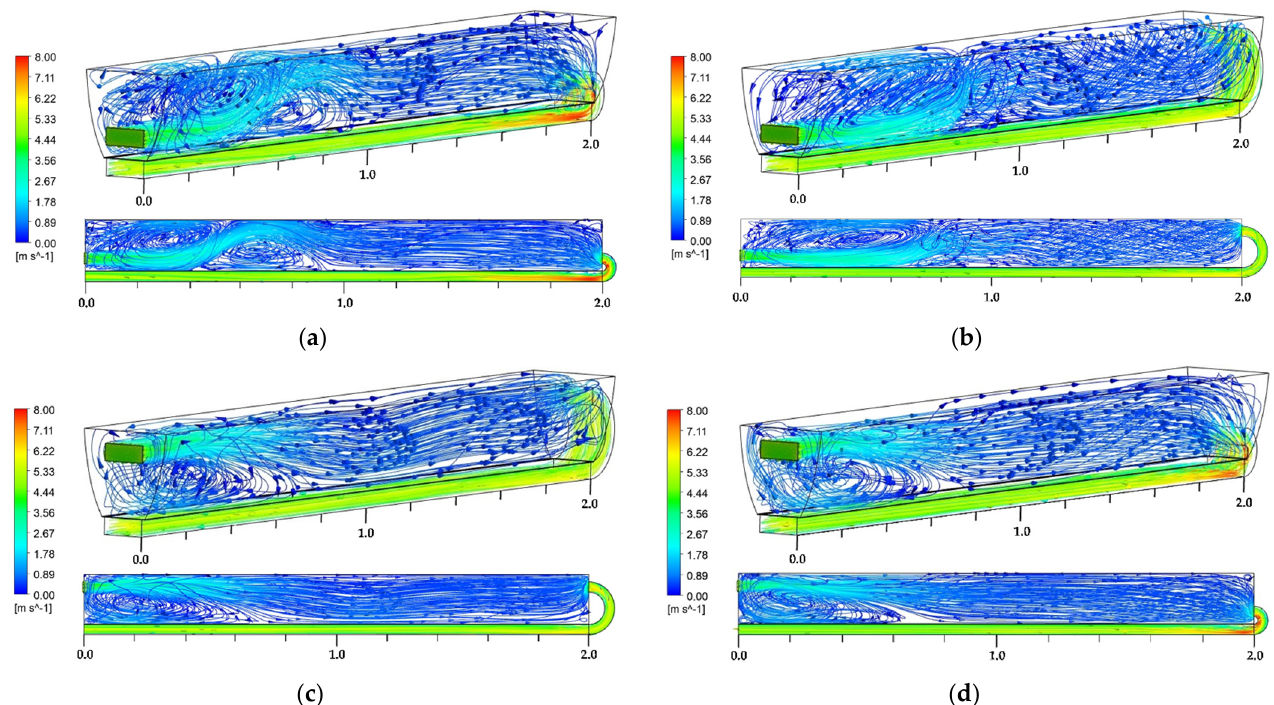
Figure 5. Streamlines at the collector cross-section with air mass flow 2: 0.02 kg/s. ( a ) Down–Down; ( b ) Down–Up; ( c ) Up–Up; ( d ) Up–Down.